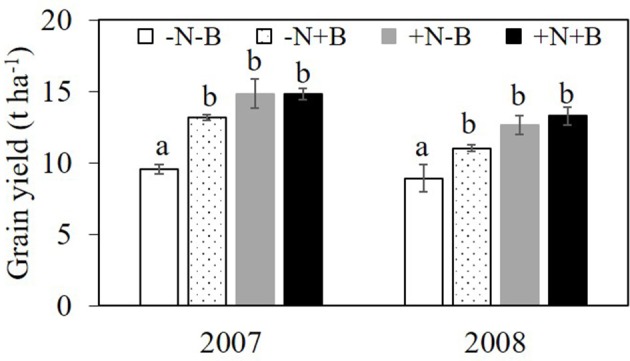
Grain yield (t ha−1) in the field experiment in 2007 and 2008. Effects of N fertilizer supplies and benomyl on maize grain yield. Each value is the mean of four replicates (±SE). Different letters above bars denote significant difference among treatments at a specific growth stage (P < 0.05). –N–B: no N fertilizer and no benomyl; –N+B: no N fertilizer and benomyl; +N–B, N fertilizer and no benomyl; +N+B, N fertilizer and benomyl.